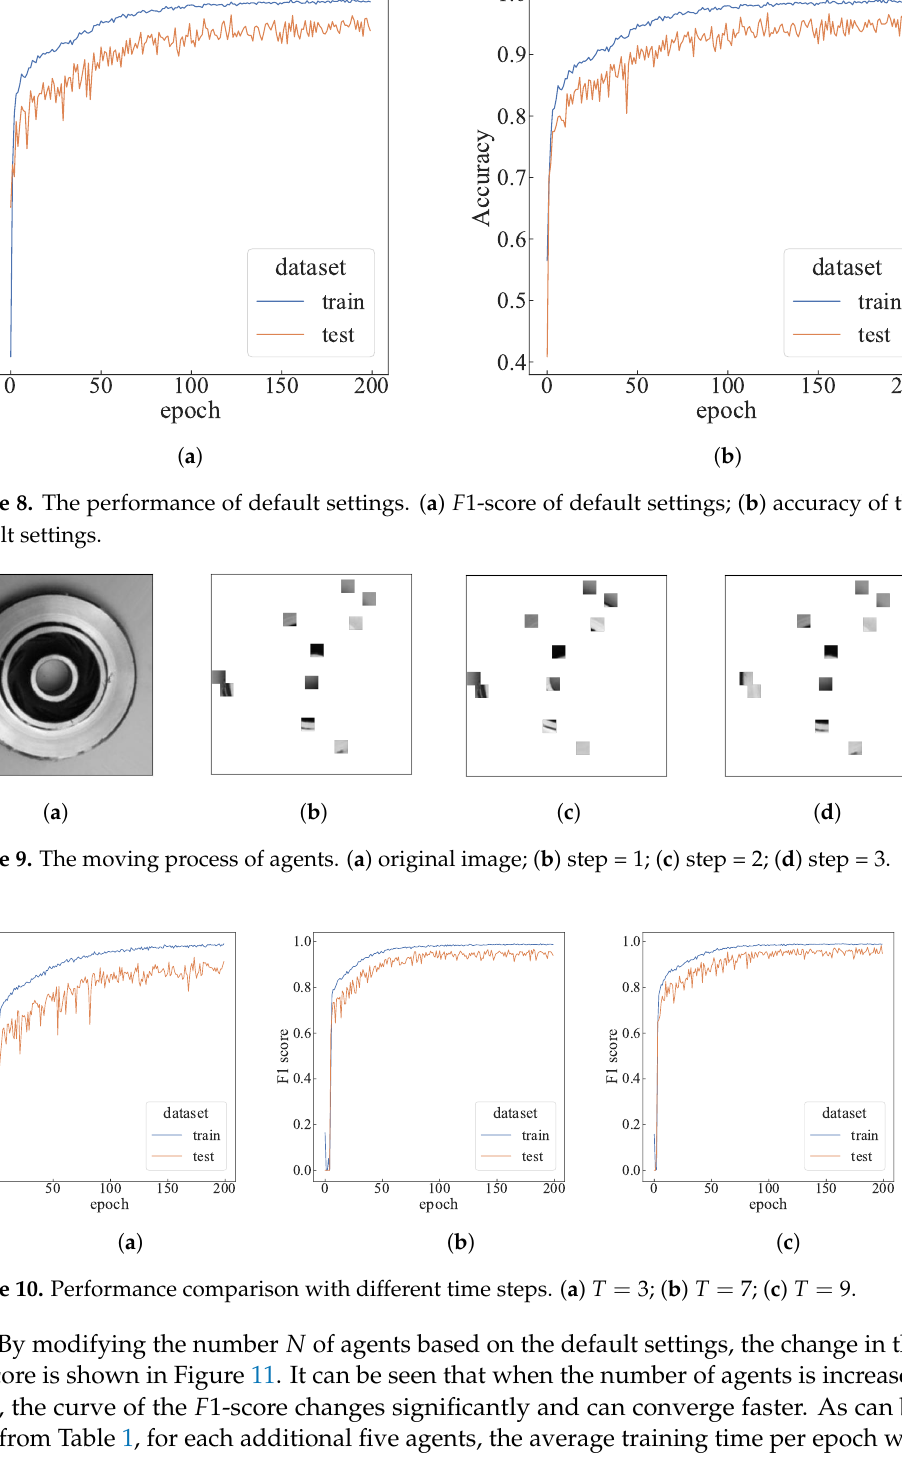
per epoch increased by